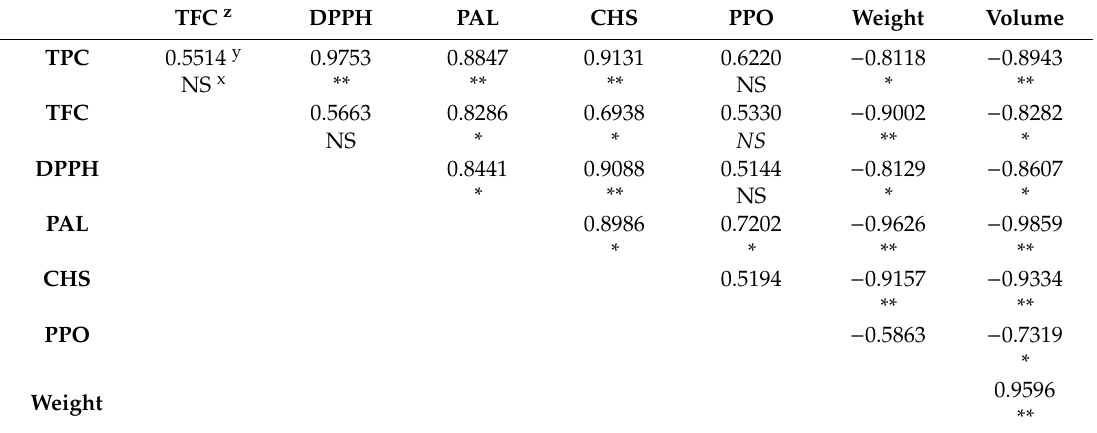
Table 3. Pearson’s correlations among enzymatic activities and fruit weight and